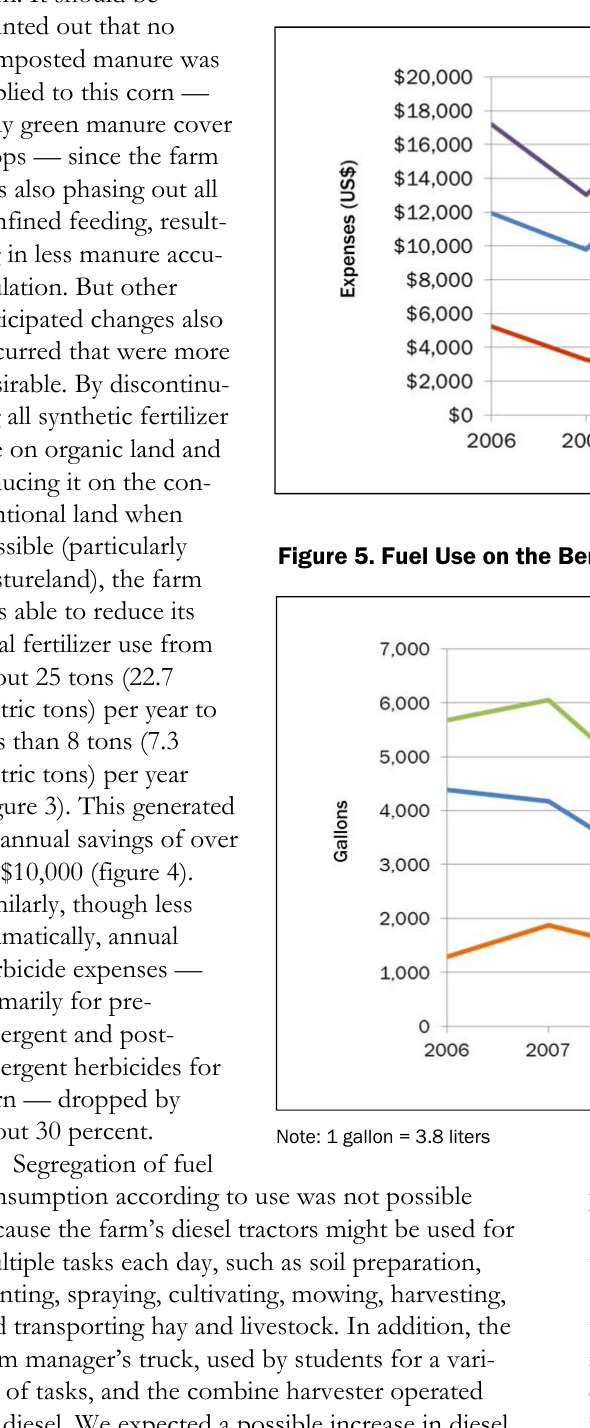
Figure 4. Fertilizer Expenses (US$) on the Berea College Student Farm, 2006–2012